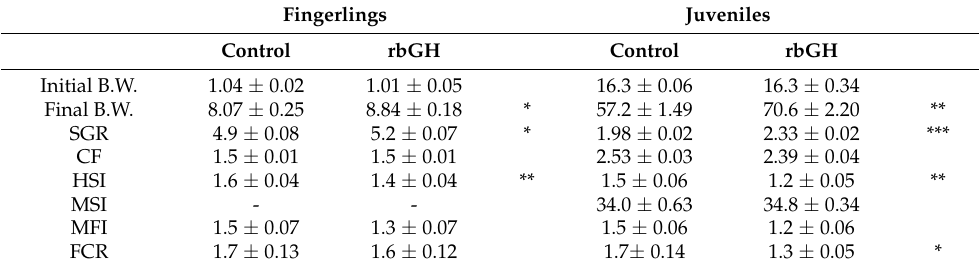
Table 1. Somatic growth parameters and feed conversion rate (FCR) after 6 and 9 weeks of rBGH injection on gilthead sea bream fingerlings and juveniles. Fingerlings Juveniles Control rbGH Control rbGH Initial